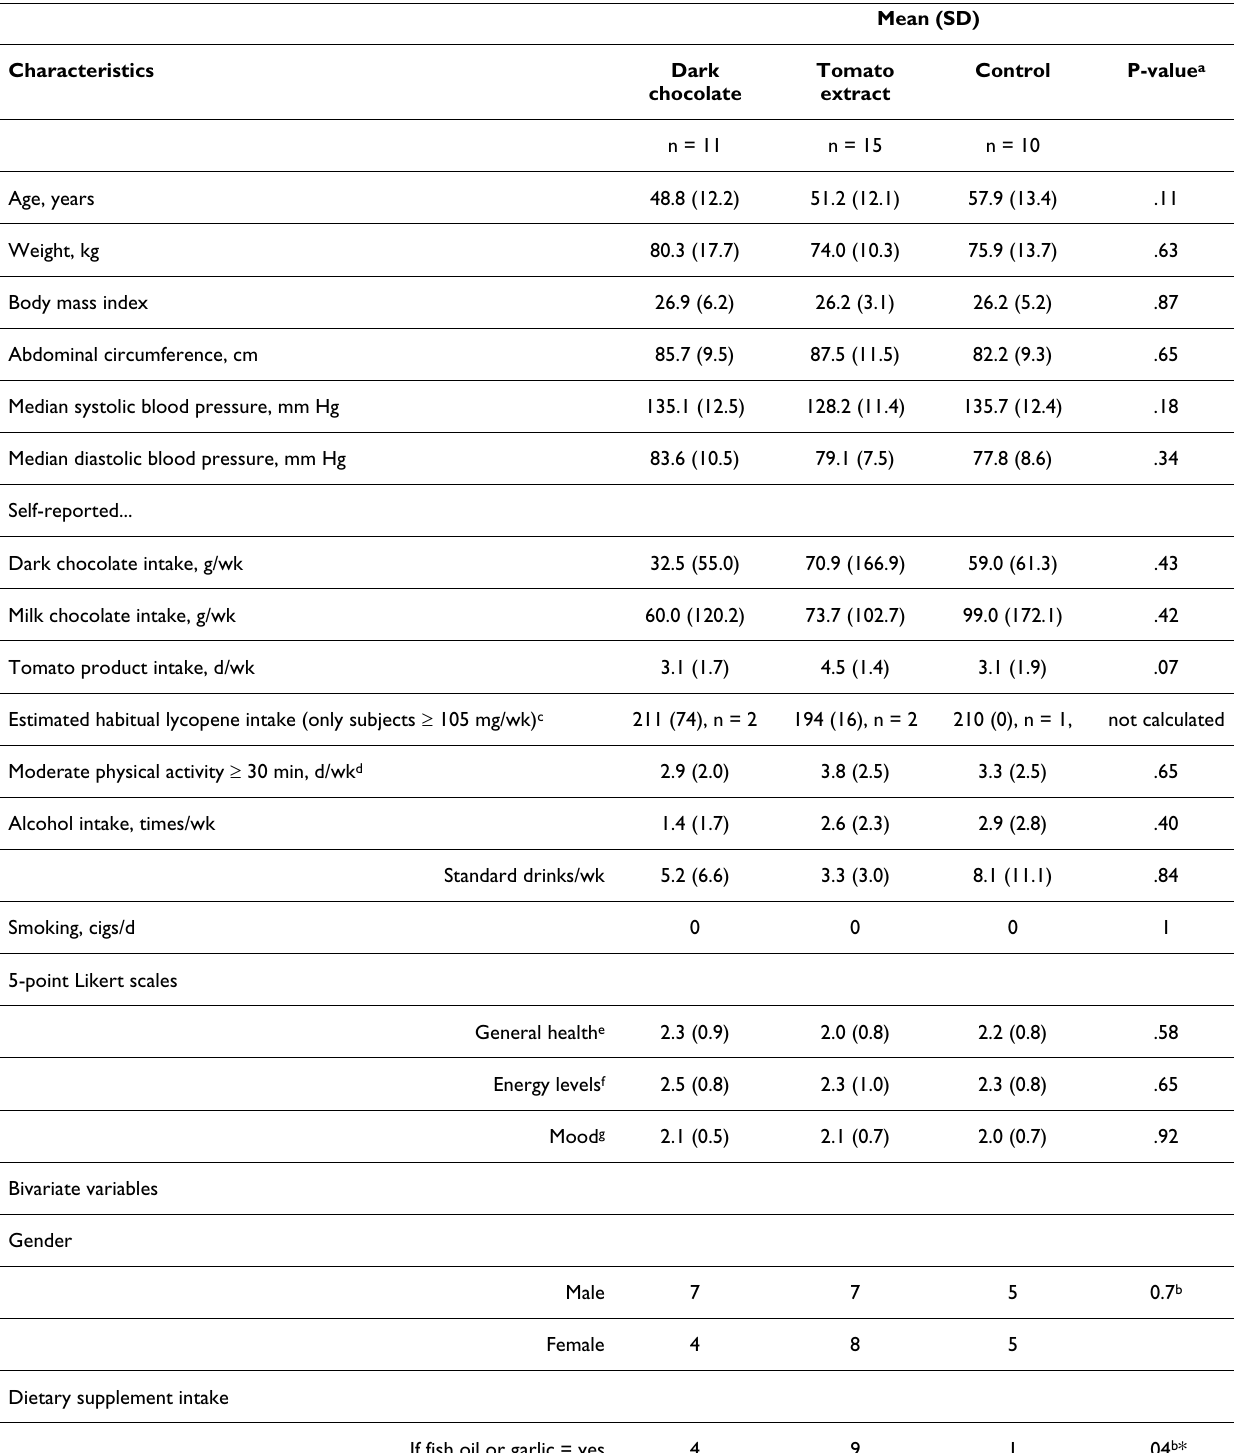
Table 1: Baseline characteristics Characteristics Dark